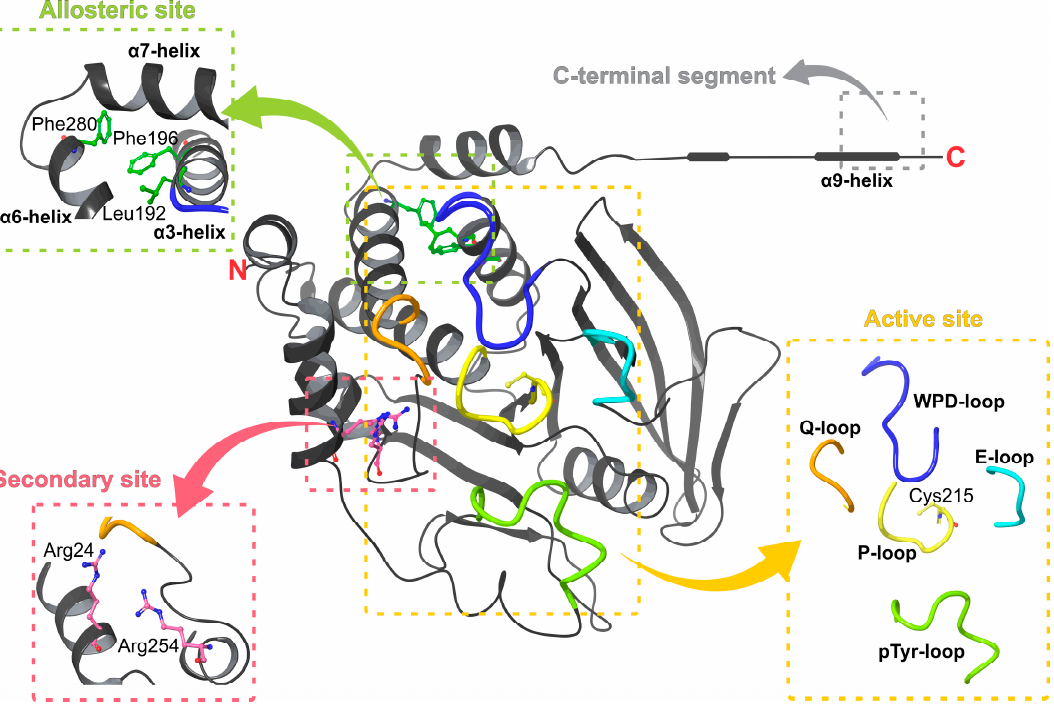
Figure 2. PTP1B catalytic domain structure. The image highlights the different sites where inhibitors have been reported.